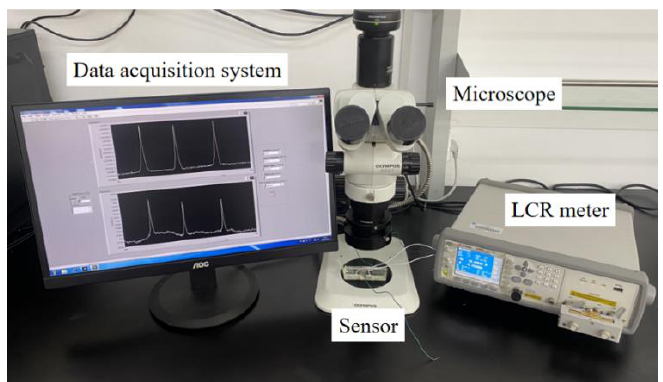
Figure 5. Photograph of test system.